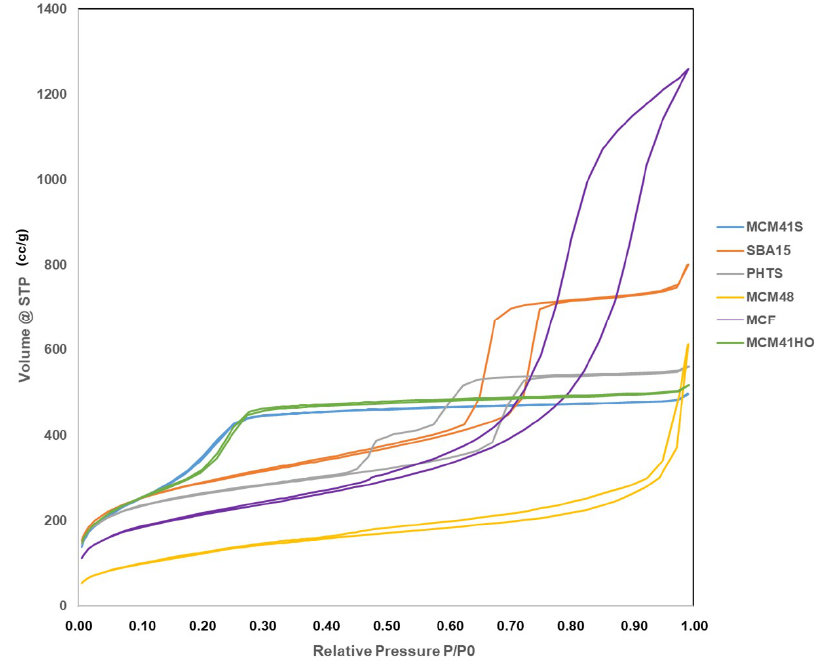
Figure 3. Nitrogen adsorption-desorption isotherms at −196 °C for MCM-41(S); MCM-41(HO); MCM- 48; SBA-15; PHTS and MCF.